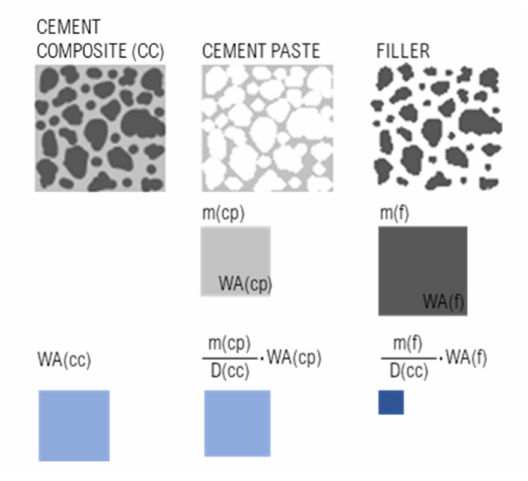
Figure 16. Graphical interpretation of Equation